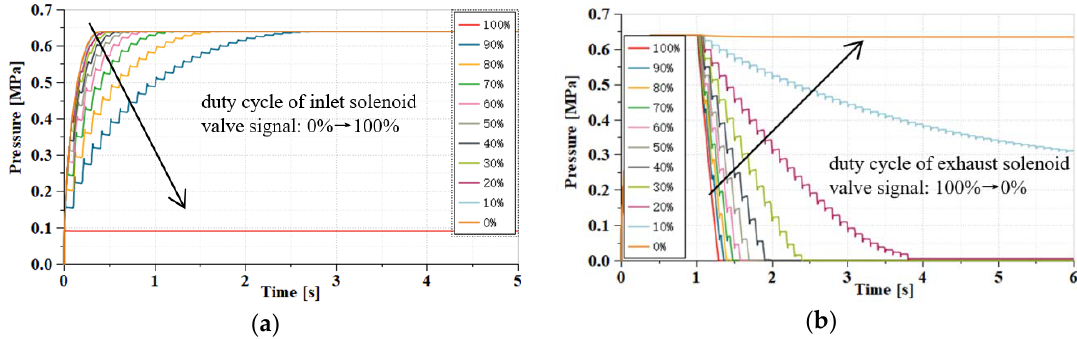
Figure 11. Pressure response of brake chamber under the control of step charging and step releasing of ABS pressure regulator. ( a ) Pressure response of step charging; ( b ) pressure response of step releasing.